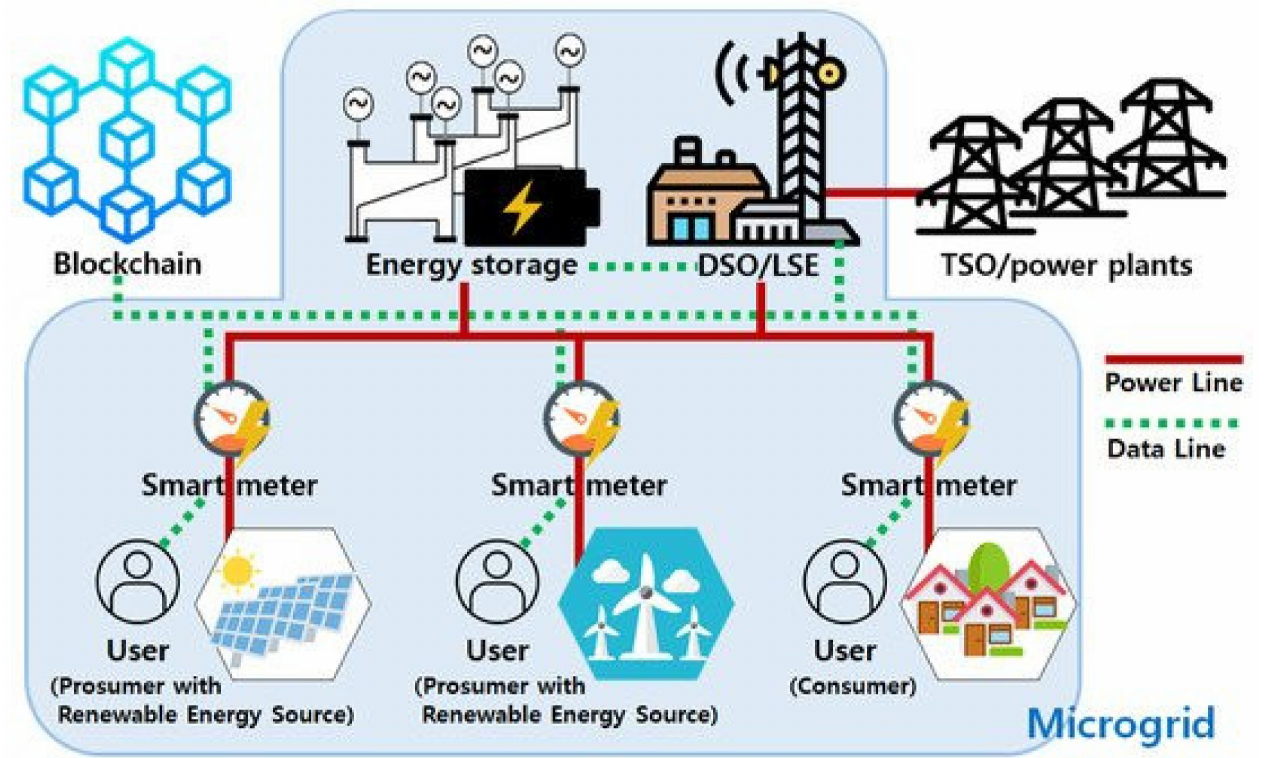
Figure 4. Microgrid scheme on the energy market